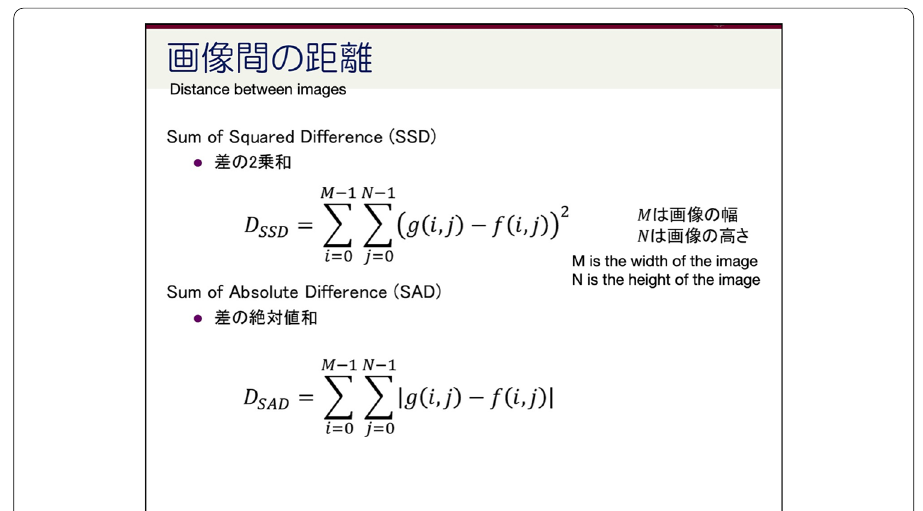
Fig. 13 An example of Type 1 page: Explanation of concept and theorem